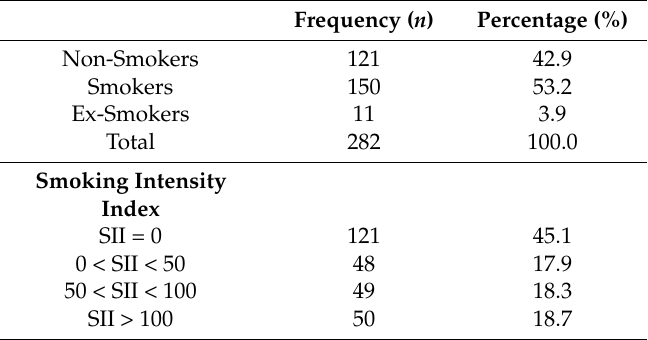
Table 3. Frequency table regarding smoking status for hrHPV positive